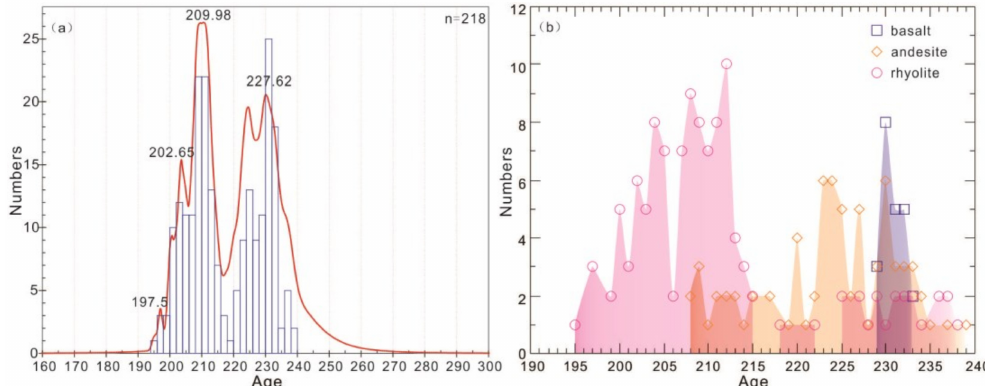
Figure 9. ( a ) Statistical analysis on the age; ( b ) Statistical analysis on the age of basalt, andesite and rhyolite of the Elashan Formation volcanic rocks in the northern margin of the EKOB (In subfigure ( a ), zircon age data from references [47,48,52,53]; this paper. In subfigure ( b ), basalt zircon age data from references [47]; andesite zircon age data from references [48,52,53]; rhyolite zircon age data from references [52,53]; this